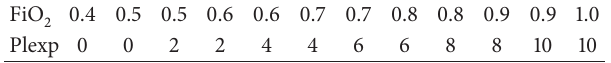
Table 1: Sliding scale of esophageal pressure-guided titration of PEEP. The table was adapted from [59]. Ventilator setting is adjusted in one column at a time to keep the partial pressure of arterial oxygen (PaO 2 ) between 55 and 120 mmHg. Alternatively, the oxygen saturation, as measured by pulse oximeter, is kept between 88 and 98% by using the ventilator settings in one column at a time. The positive end-expiratory pressure (PEEP) is set at such a level that transpulmonary pressure during end-expiratory occlusion (PLexp) stays between 0 and 10 cmH 2 O and keeps transpulmonary pressure during end-inspiratory occlusion at less than 25 cmH 2